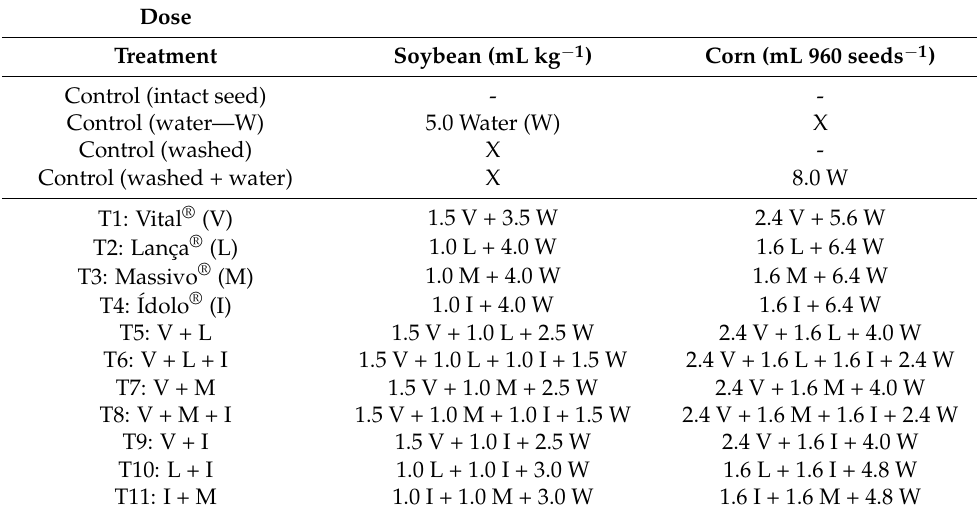
Table 8. Treatment of soybean NS7667 IPRO and corn MG744 PWU seeds with different mineral fertilizers, formulated products, and respective doses applied according to the weight or number of seeds used per soybean and corn sample. Dose Treatment Soybean (mL kg − 1 ) Corn (mL 960 seeds − 1 ) Control (intact seed) -